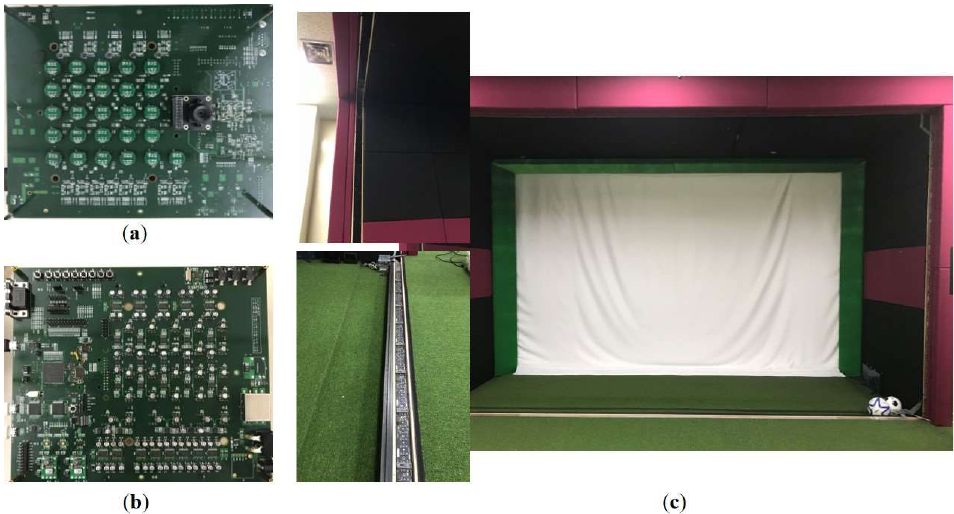
Figure 7. System implementation: ( a ) arrangement of the MEMS microphone array; ( b ) controller for impulsive sound source localization; and ( c ) ball motion scanning frame.